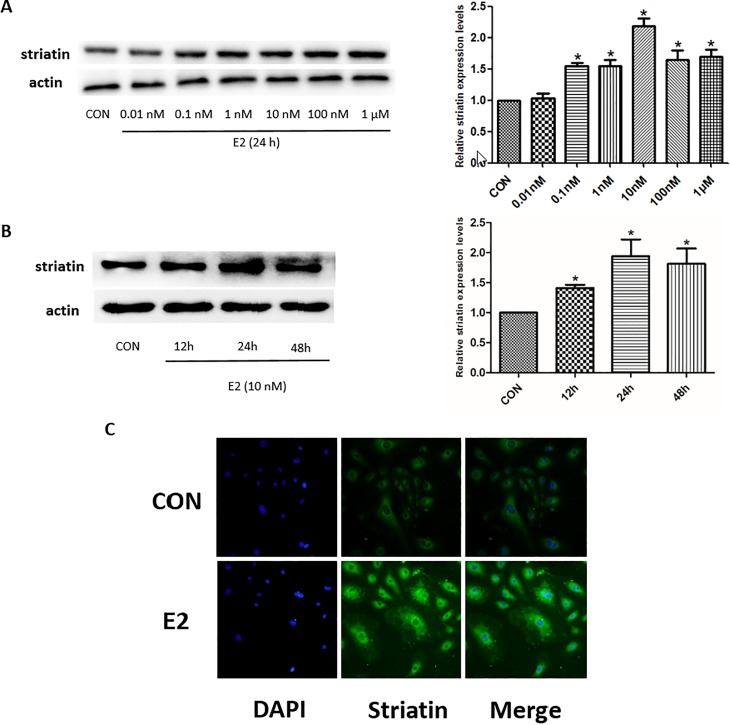
E2 upregulated striatin expression in HUVECs.(A) and (B) show the dose- and time-dependent striatin protein expression in HUVECs after treatment with E2. Striatin densitometry values were adjusted to actin intensity, then normalized to expression from the control sample. Expression in CON group was normalized to 1, *p<0.01 versus CON. Bars represent SD, n = 4. (C) HUVECs were treated with E2 (10nM) for 24h. Then the cells were stained with anti-striatin linked to FITC. Nuclei were counterstained with DAPI.